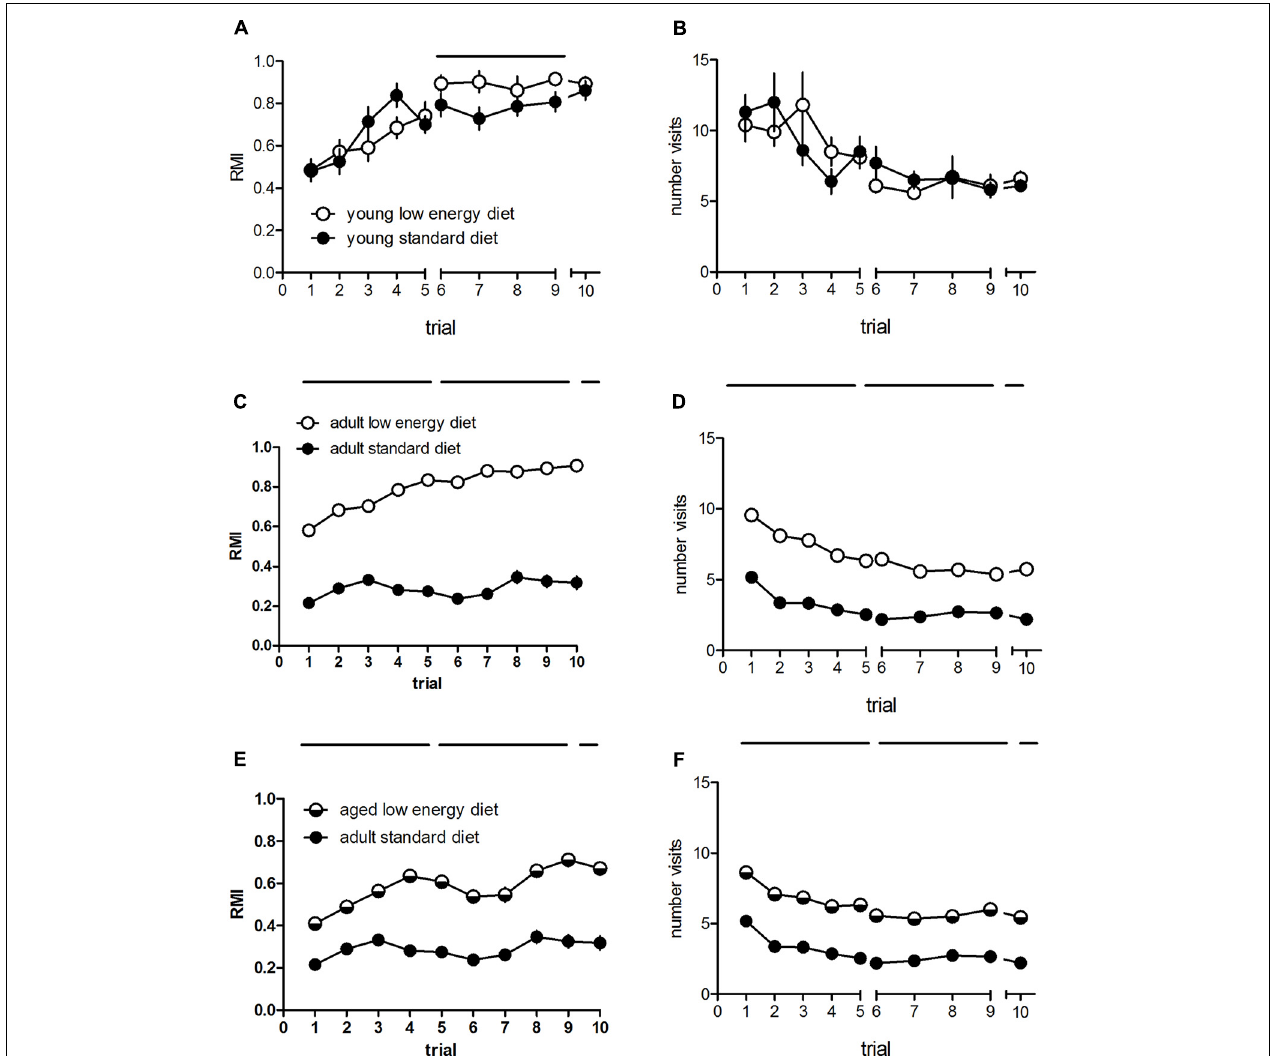
FIGURE 1 | Reference memory indices (A) and numbers of total hole visits (B) of young ( n = 10, each) and adult rats under standard ( n = 162) and low energy diet ( n = 120). (C,D) Reference memory indices (E) and total hole visits (F) of adult rats under standard diet (162) and the same rats when aged under low energy diet ( n = 127). Horizontal bars indicate statistically significant differences between groups. Given are the means and standard errors of means.